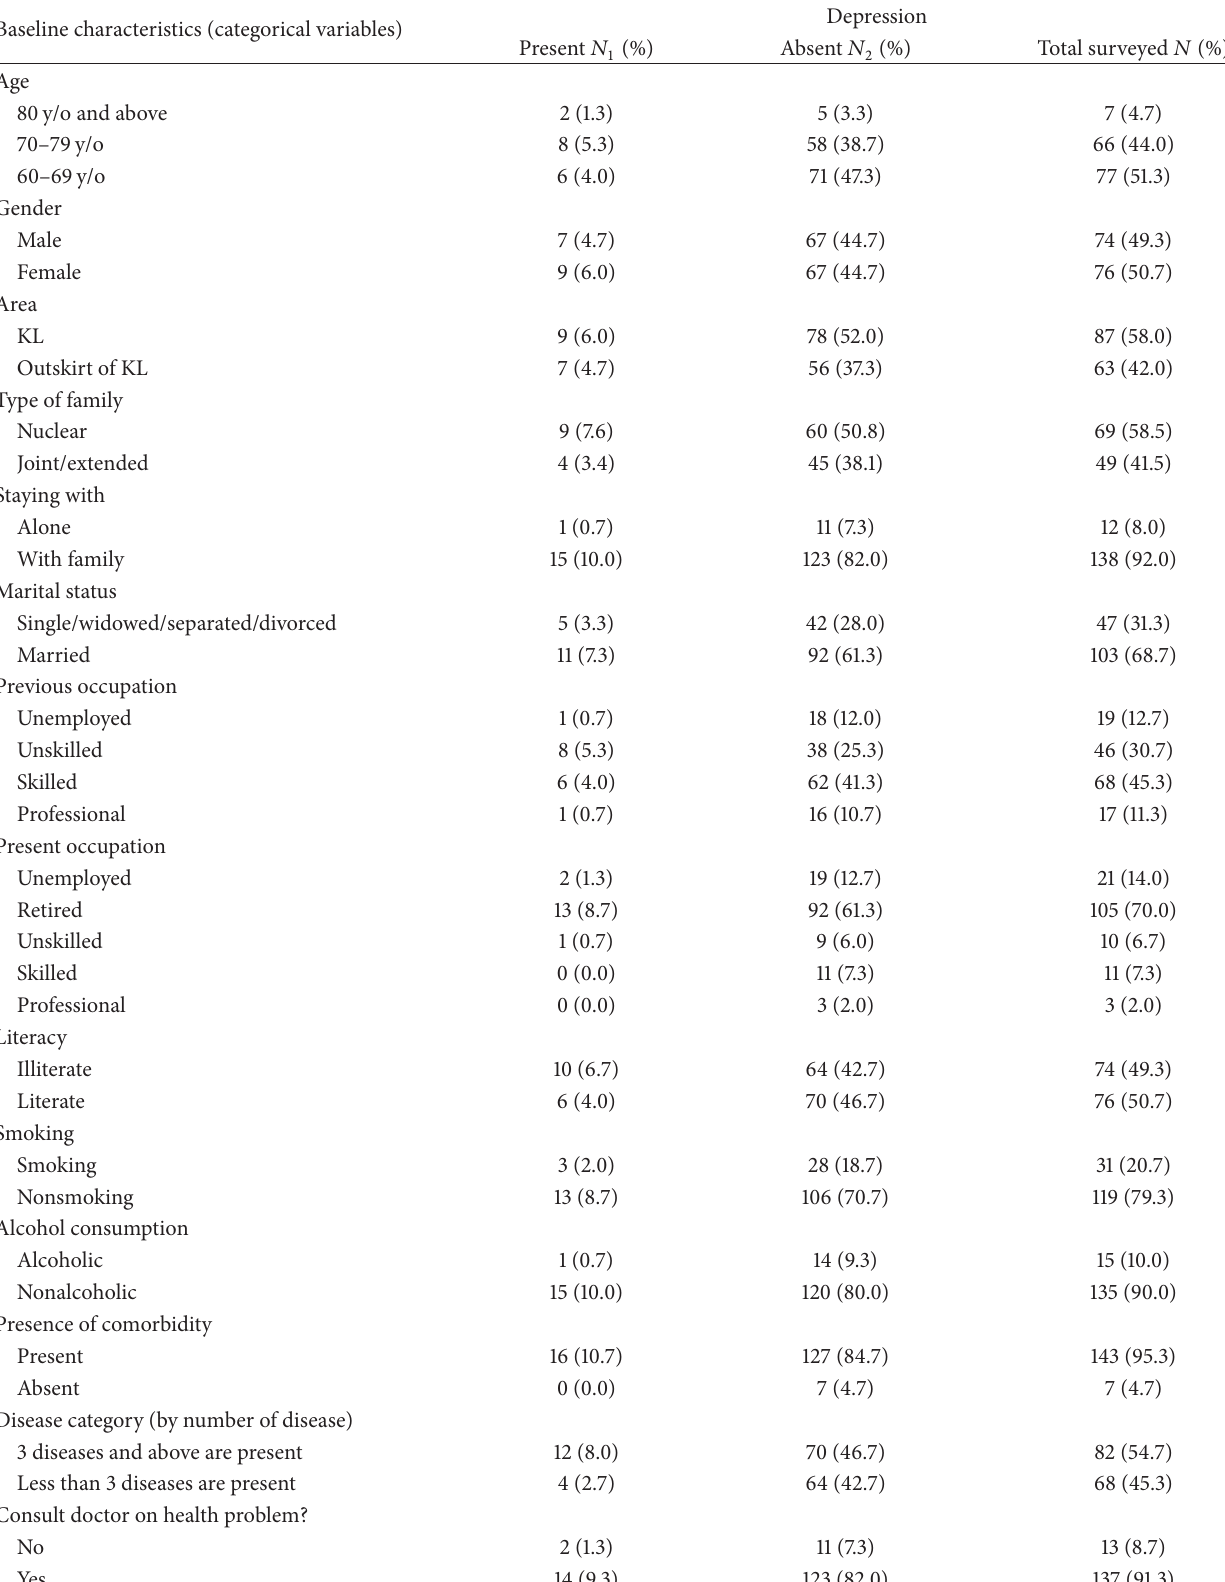
Table 1: Sociodemographic profile of the elderly Chinese in Klang Valley, Malaysia (categorical